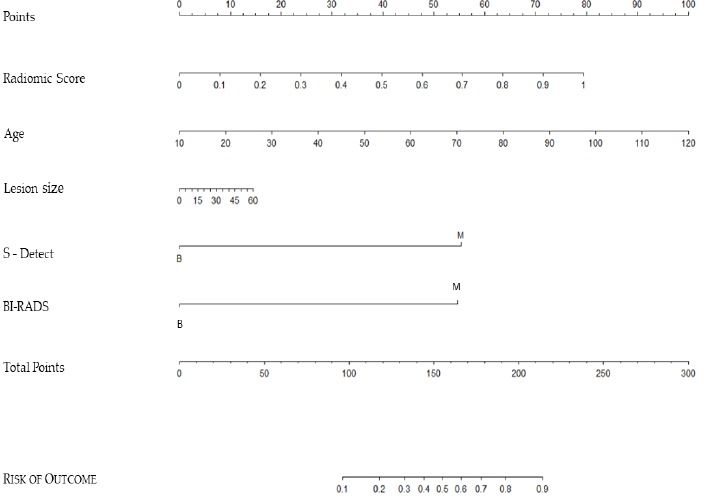
Figure 3. Nomogram for the prediction of breast malignancy using the adjusted radiomic model, S-Detect CAD system, and BI-RADS evaluation.